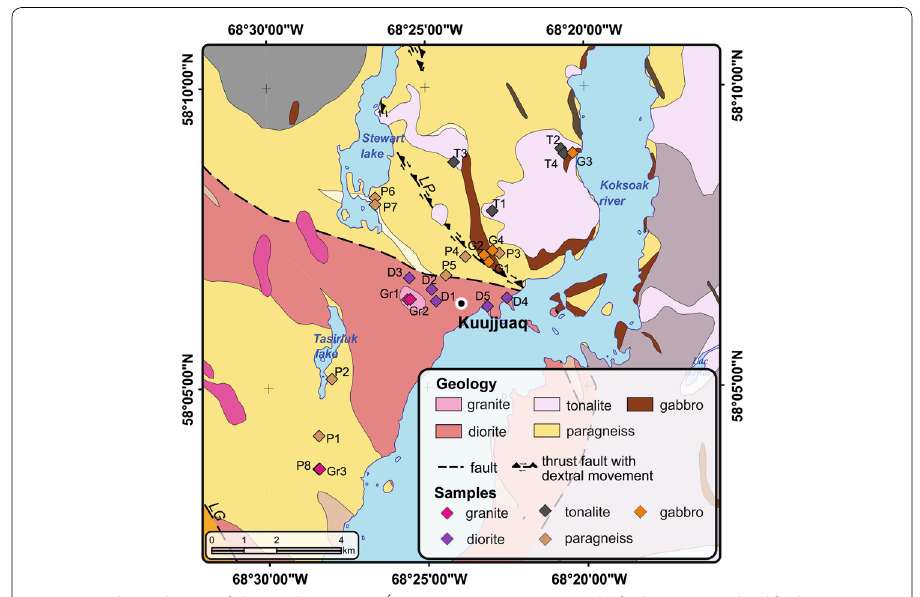
Fig. 2 Geological map of the study area (SIGÉOM 2019). LP Lac Pingiajjulik fault, LG Lac Gabriel fault, P paragneiss, D diorite, G gabbro, T tonalite, Gr